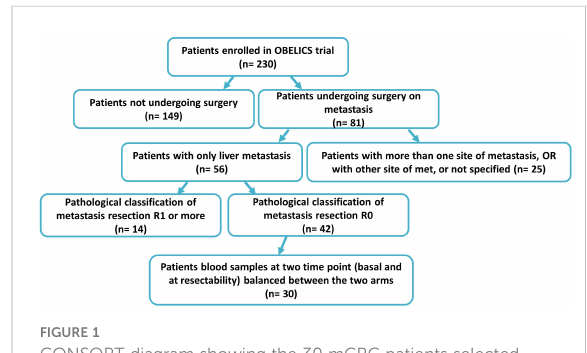
FIGURE 1 CONSORT diagram showing the 30 mCRC patients selected.